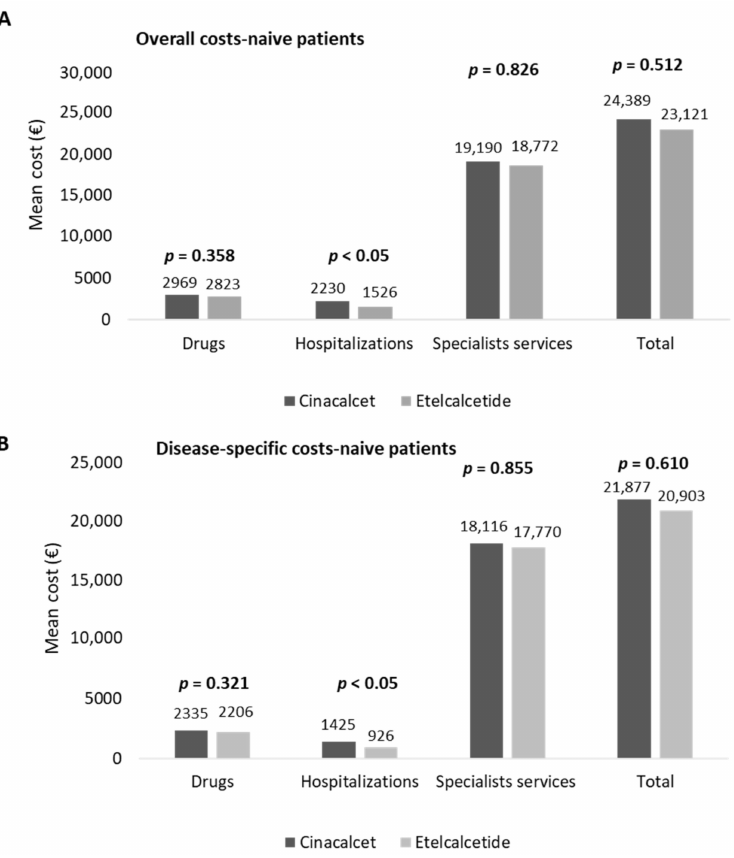
Figure 4. Healthcare mean total costs related to overall ( A ) and disease-specific ( B ) resource con- sumption in naive cinacalcet- and etelcalcetide-treated cohorts,